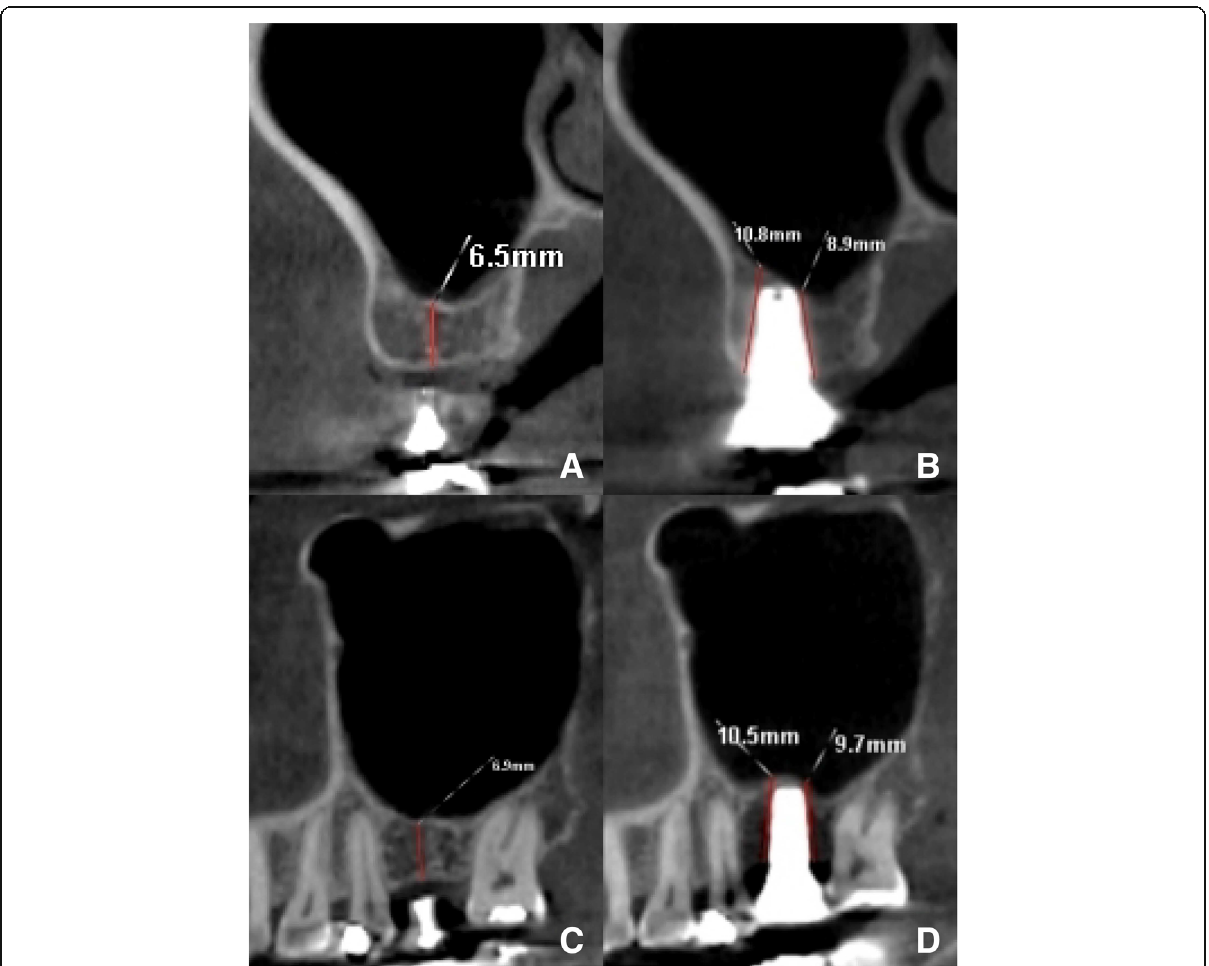
Fig. 1 Case 1: The CBCT images of implant site 16 before (left column) and 6 months after surgery (right column). The residual bone height (RBH) was measured from the cortex bone to the alveolar bone crest under the sinus floor in a coronal and c sagittal views. The new bone level was measured from the most coronal implant thread to the most apical visible implant at b buccal and palatal sites in coronal view and d mesial and distal sites in sagittal